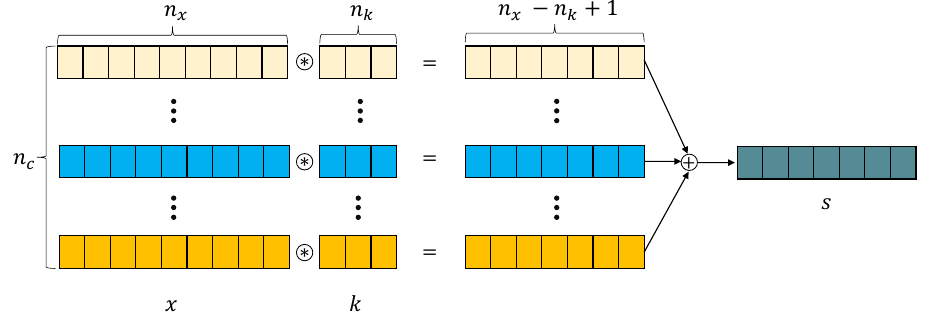
Figure 3. 1D convolution operation with a multi-channel kernel on multi-channel